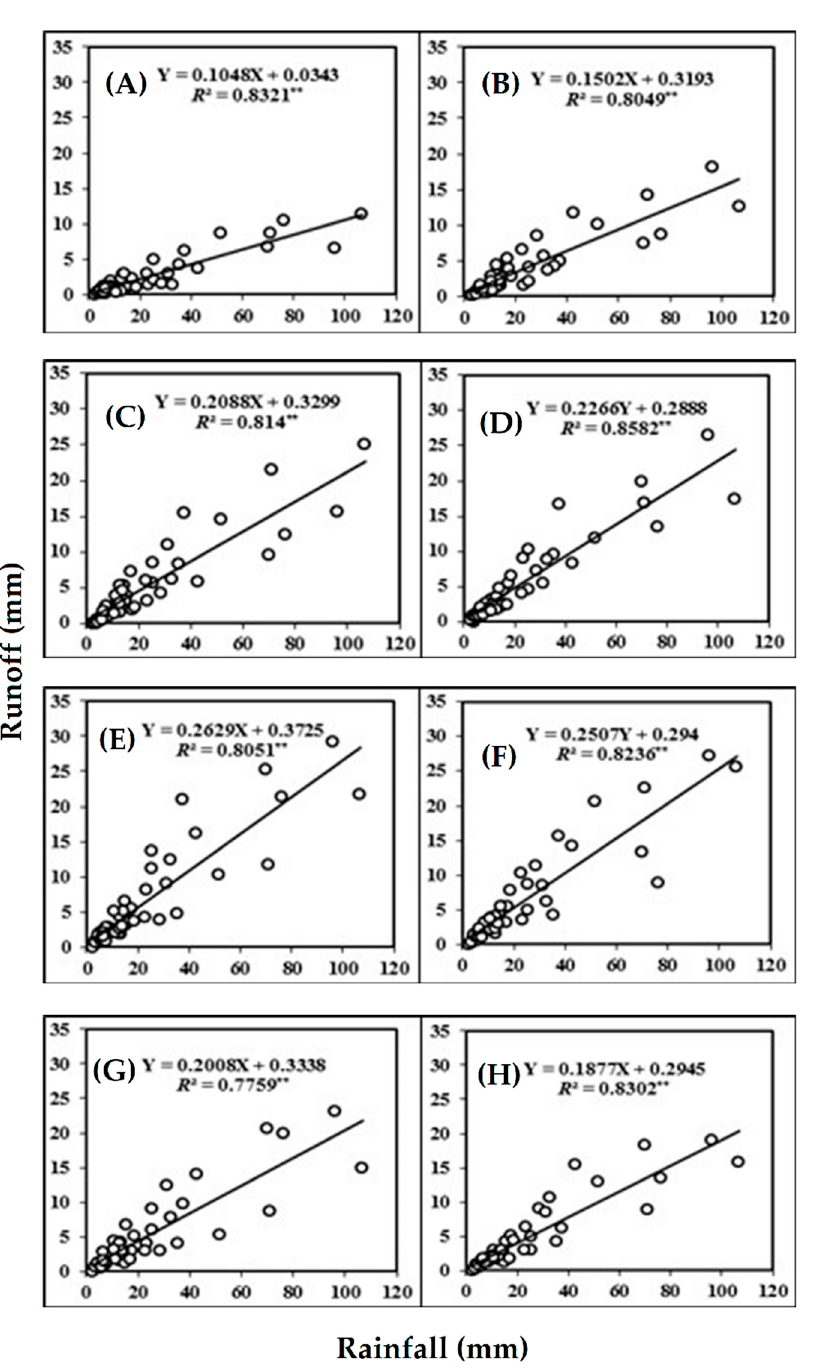
Figure 2. Relationship between rainfall versus runoff on plots with different slope gradients of ( A ) 5%, ( B ) 10%, ( C ) 15%, ( D ) 20%, ( E ) 25%, ( F ) 30%, ( G ) 35% and ( H ) 40%. For each graph, the regression equation and the coefficient of determination ( R 2 ) are given. Note: ** P < 0.01.